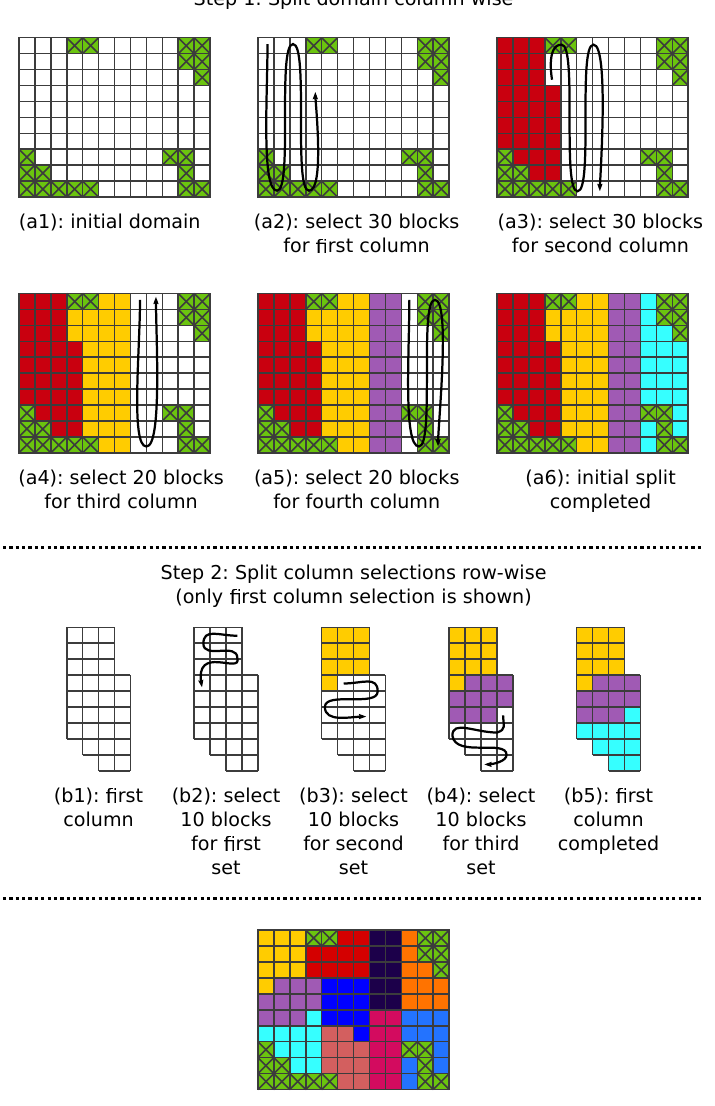
Fig. 4. Description of the hierarchical load-balancing scheme for an example of 12 × 10 blocks, of which 20 are land-only blocks, as shown in panel (a1) . The initial column-wise split is shown in panels (a2) – (a6) , the next row wise split in the panels (b1) – (b5) , and the final results is shown in panel (c) .